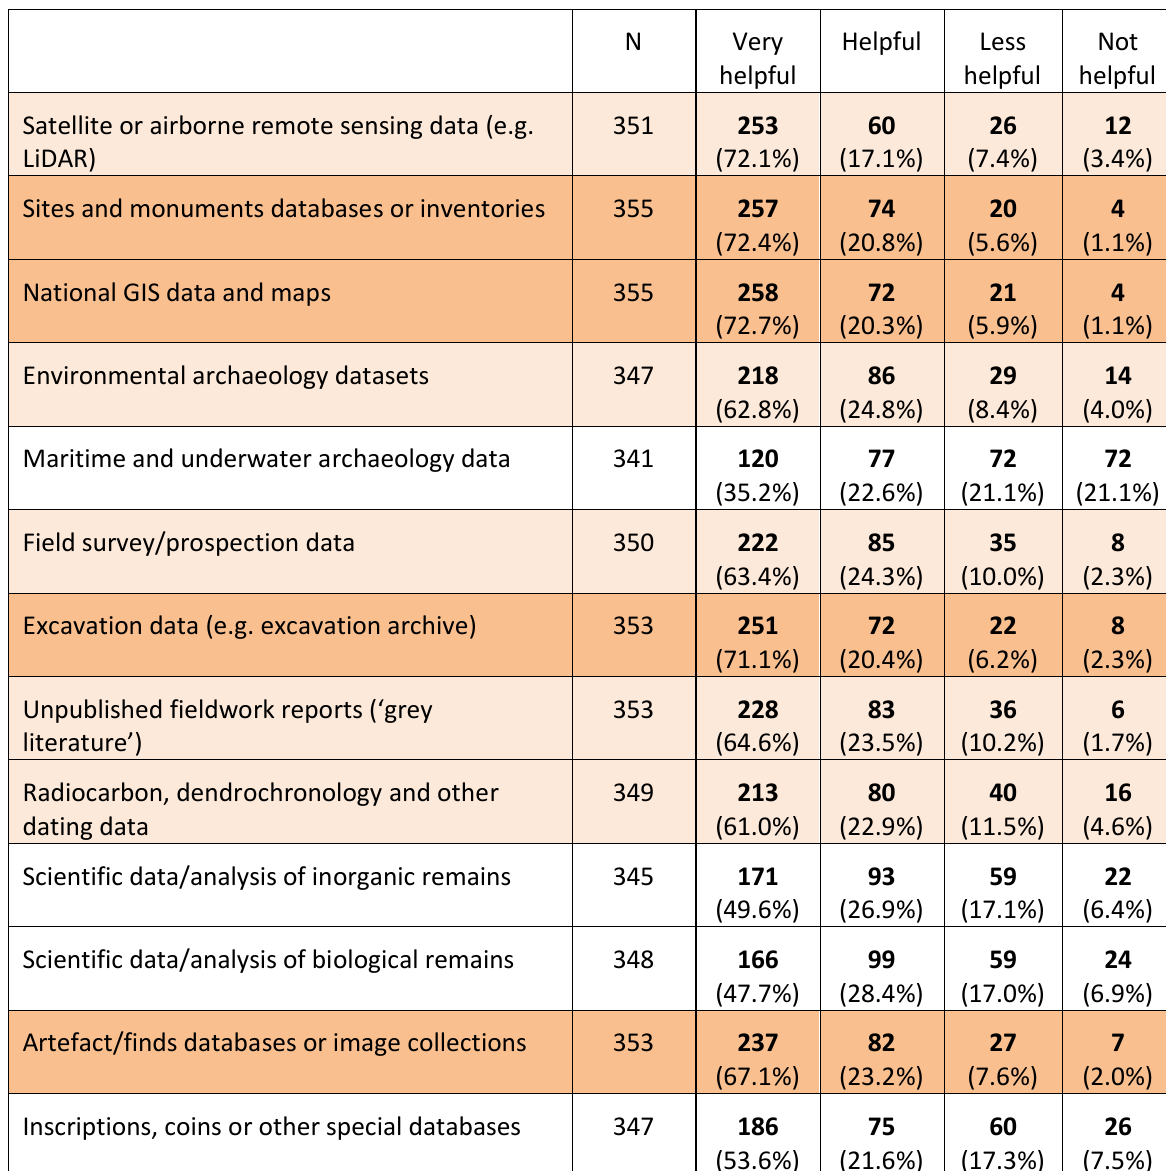
Table 18.2 : Results for collection/dataset-level discovery & access on the ARIADNEplus portal for different types of data (N =